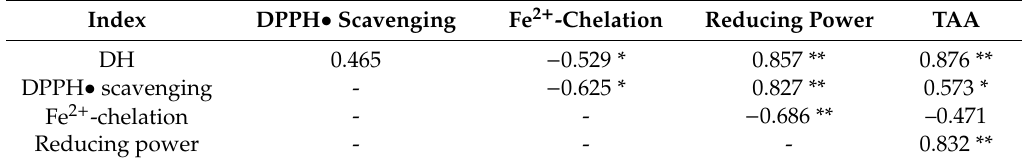
Table 1. Correlation analysis between degree of hydrolysis (DH) and antioxidant activity of ESM-EH. Index DPPH • Scavenging Fe 2 + -Chelation Reducing Power TAA DH 0.465 − 0.529 * 0.857 ** 0.876 ** DPPH • scavenging - − 0.625 * 0.827 ** 0.573 * Fe 2 + -chelation - - − 0.686 ** –0.471 Reducing power - - - 0.832 ** * Indicates significant ( p < 0.05) and ** indicates highly significant ( p < 0.01). TAA: total antioxidant